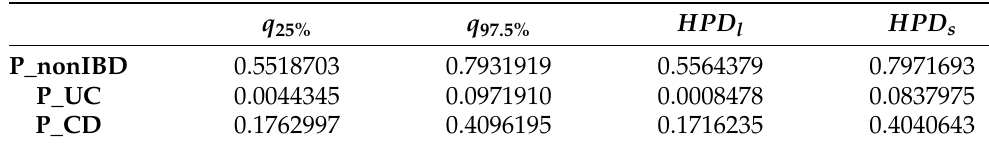
Table A1. 95% credible intervals: A_nonIBD .